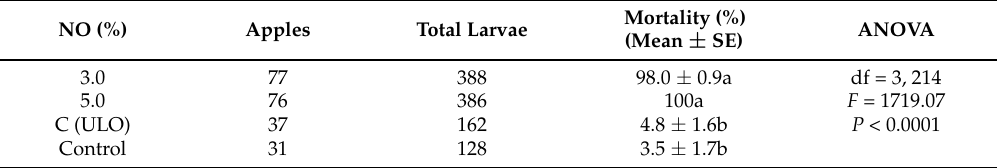
Table 3. Effects of 24 h nitric oxide fumigation treatments at 2 ◦ C on mortality of codling moth larvae in